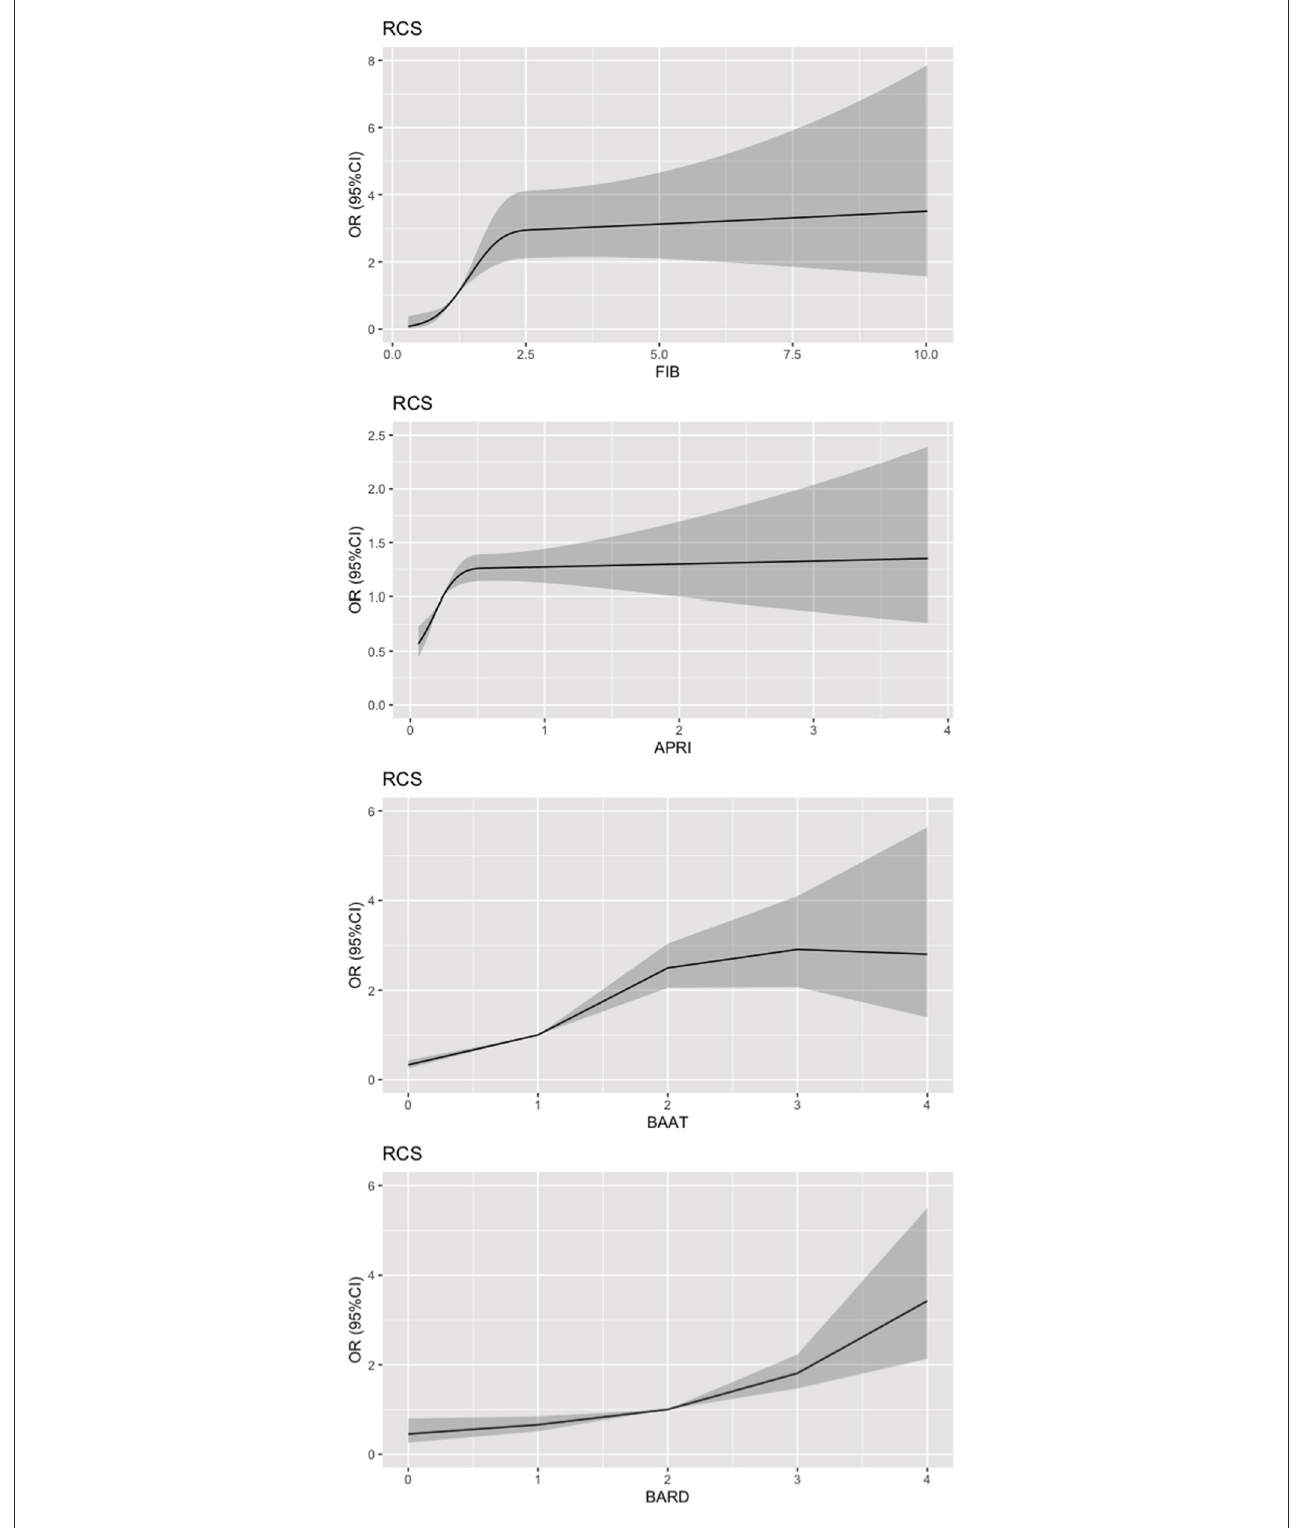
FIGURE2 Restricted cubic spline plot of liver fibrosis scores and CKD. The vertical axis is the OR between LFS and CKD. The horizontal axis is the liver fibrosis score.